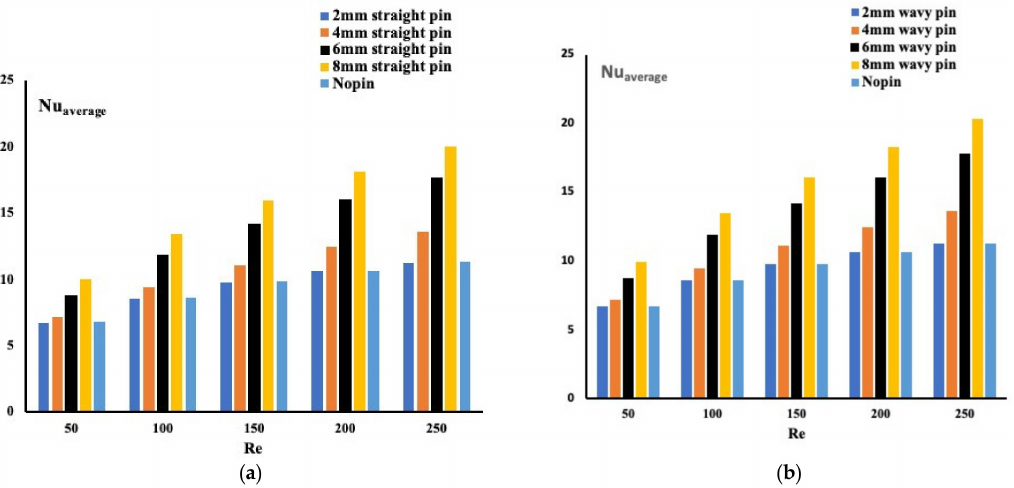
Figure 4. Average Nusselt number for different configuration (( a ) Straight pin-fins configuration, ( b ) Wavy pin-fins